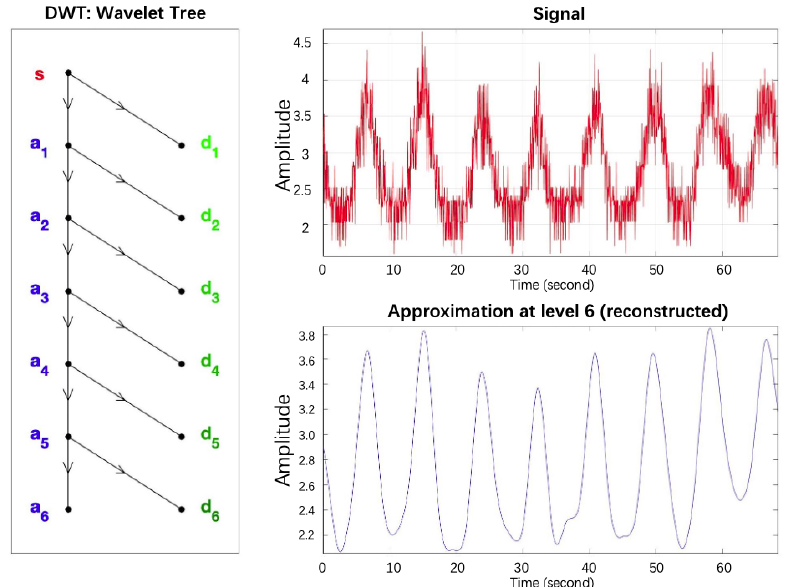
Figure 9. Wavelet decomposition